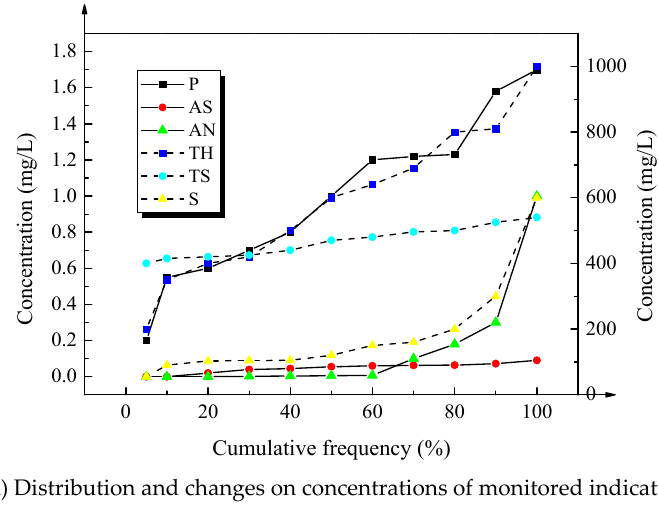
Table 2. Water quality level and content of permanganate, total hardness, and ammonia nitrogen.